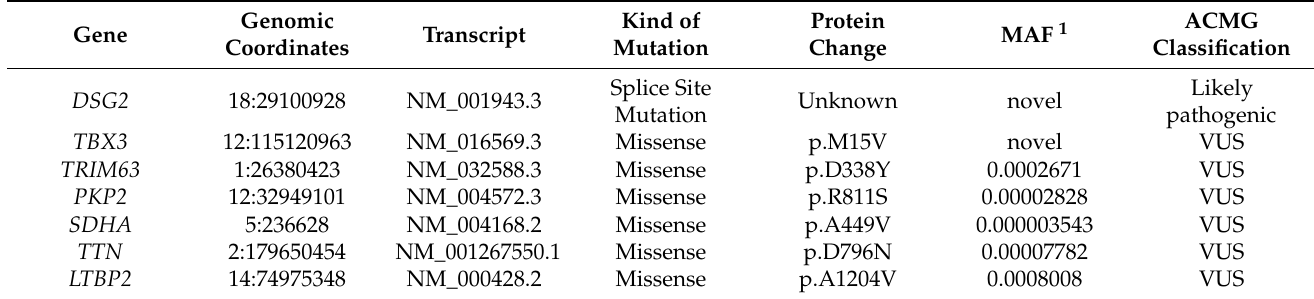
Figure 5. Cardiac magnetic resonance imaging (MRI) of the I-1 ( A ), I-2 ( B,D–F ), and II -1 ( C ) of Family B. Asterisk indicates non-compaction layer. Table 1. List of rare variants (MAF < 0.001) identified in the index patient II-1 (Family